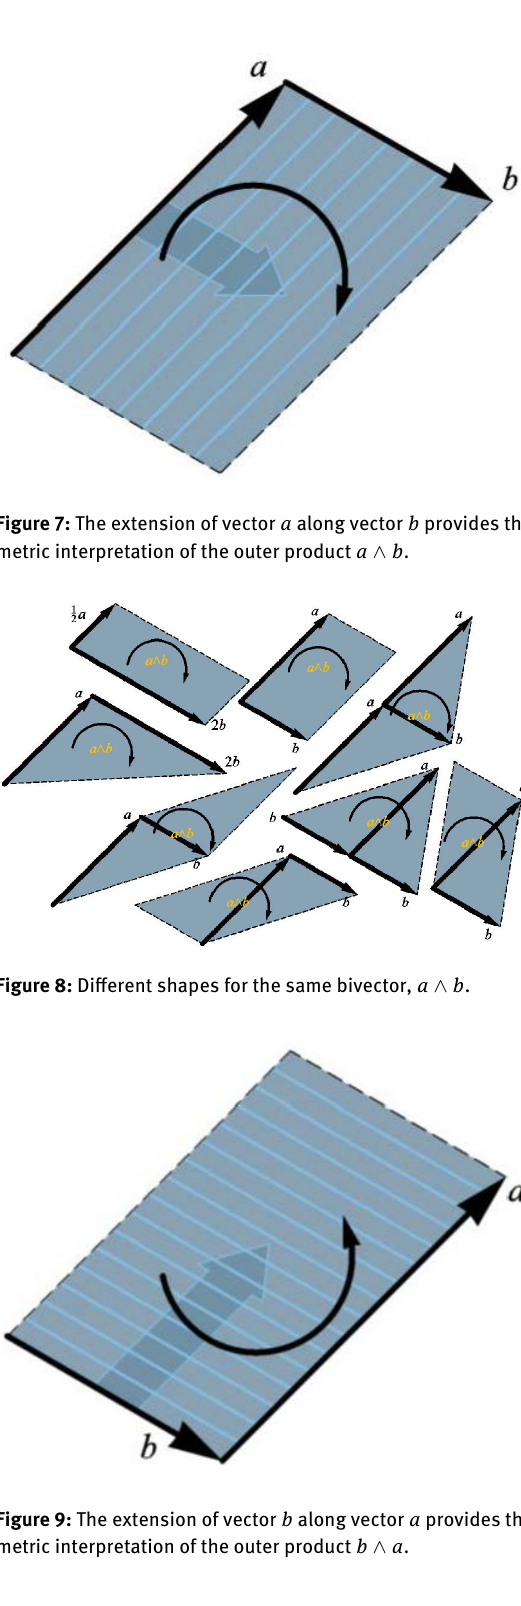
plex numbers, we keep the real and imaginary parts sep- arated. Being the sum of a scalar and a bivector, the geo-